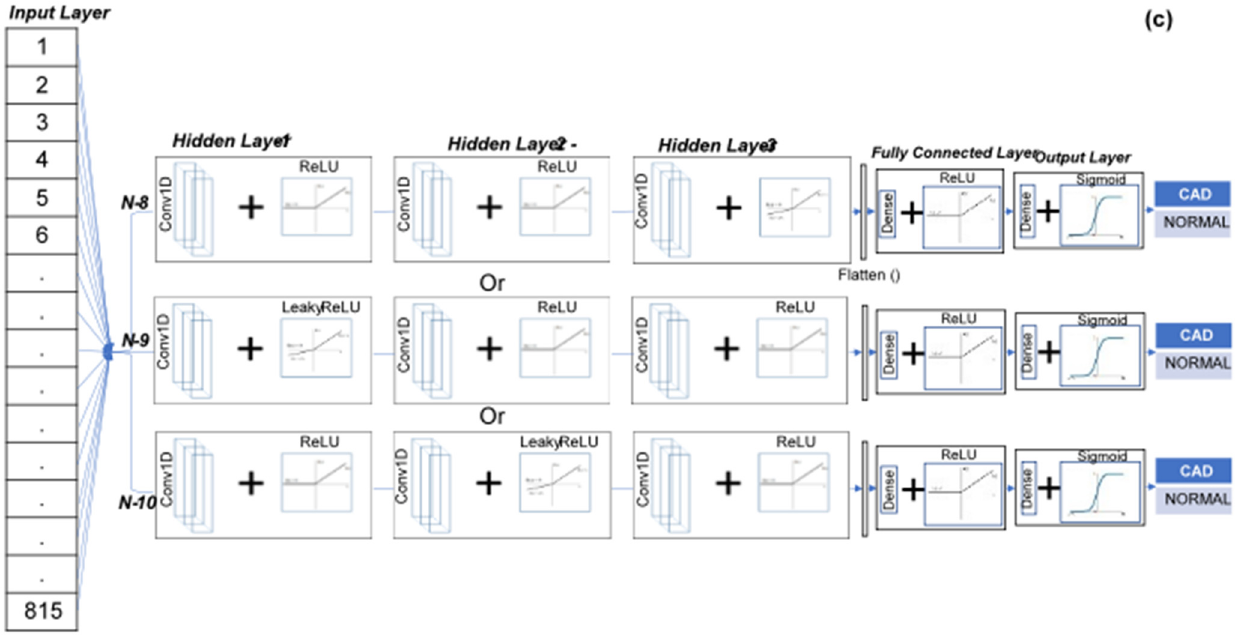
Figure 9. ( a ) Single CNN layer, ( b ) double CNN layer, and ( c ) triple CNN layer for the single-lead ECG/TMT-ECG.